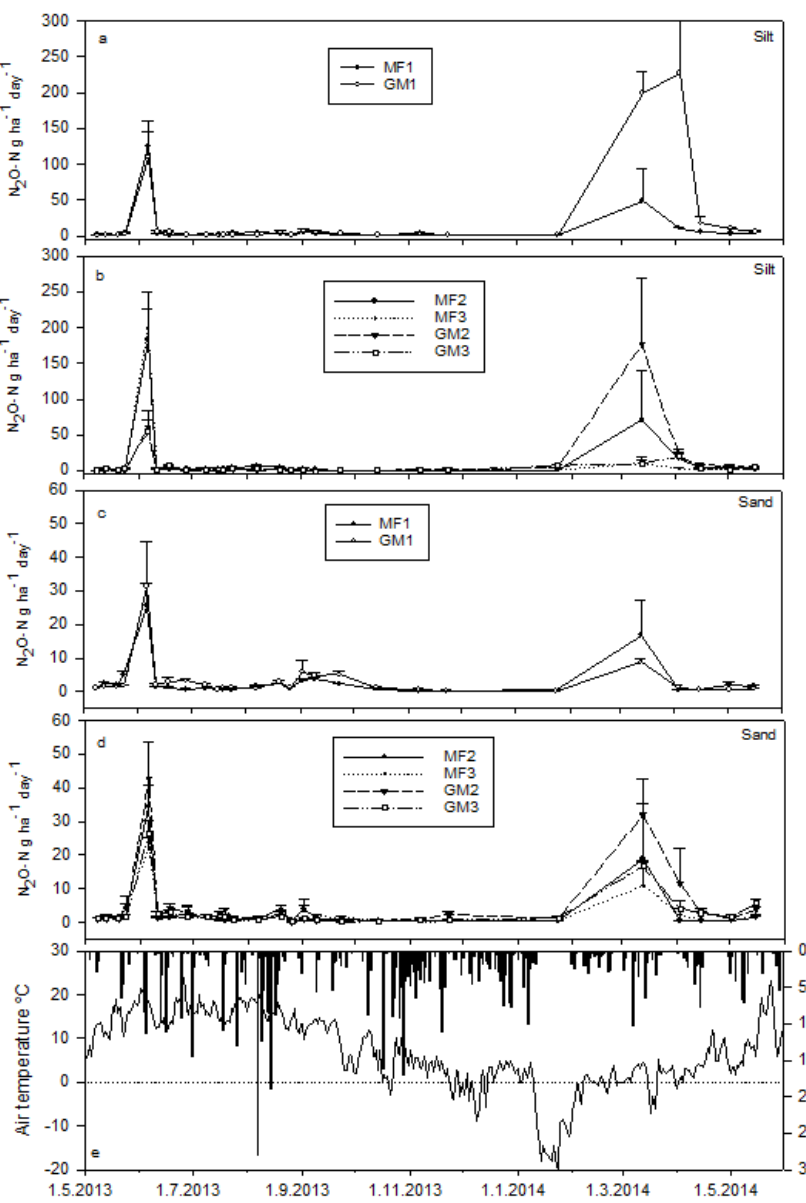
Fig. 3. Emissions of N O (± positive standard error) from different green manure or fertilizer treatments (n=4) 2 for winter wheat in silt soil (a) and sandy soil (c) and for spring wheat in silt soil b) and sandy soil (d) and daily temperature and precipitation (e). MF1=mineral fertilizer + winter wheat, MF2=mineral fertilizer + spring wheat (straw mulching in autumn), MF3=mineral fertilizer + spring wheat (straw mulching in spring), GM1=green manure mulched in August + winter wheat, GM2=green manure mulched in October + spring wheat, GM3=green manure mulched in spring + spring wheat. Note different scales of the y-axis for the soil